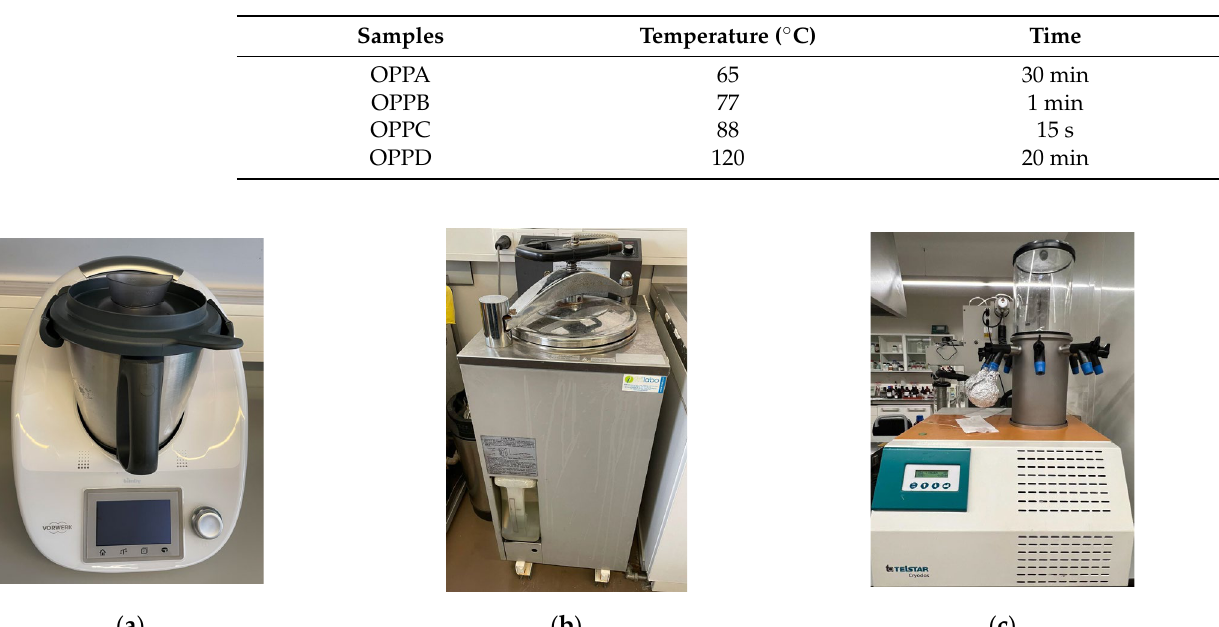
Figure 2. Olive pomace paste. Table 6. Time/temperature binomials applied to the olive pomace paste (OPP).